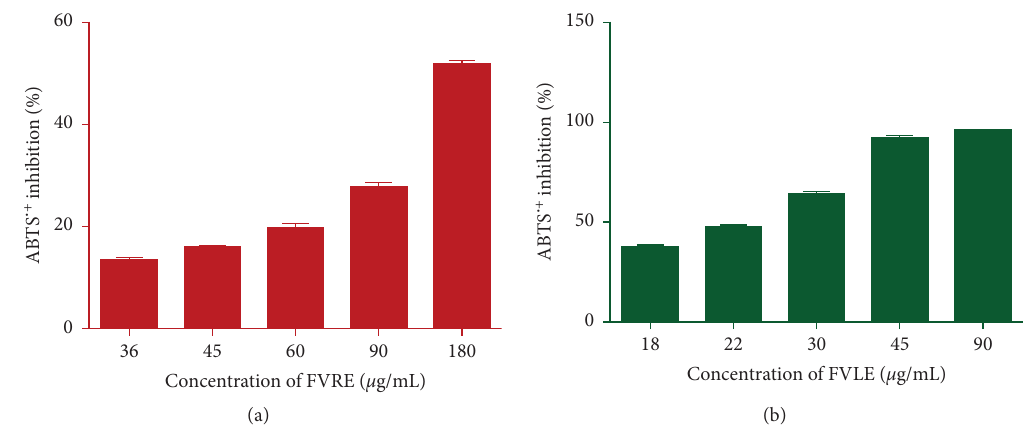
Figure 2: ABTS radical scavenging activity of F. vulgare leaf and rootstock aqueous extracts. The values are the mean of three deter- minations ± standard